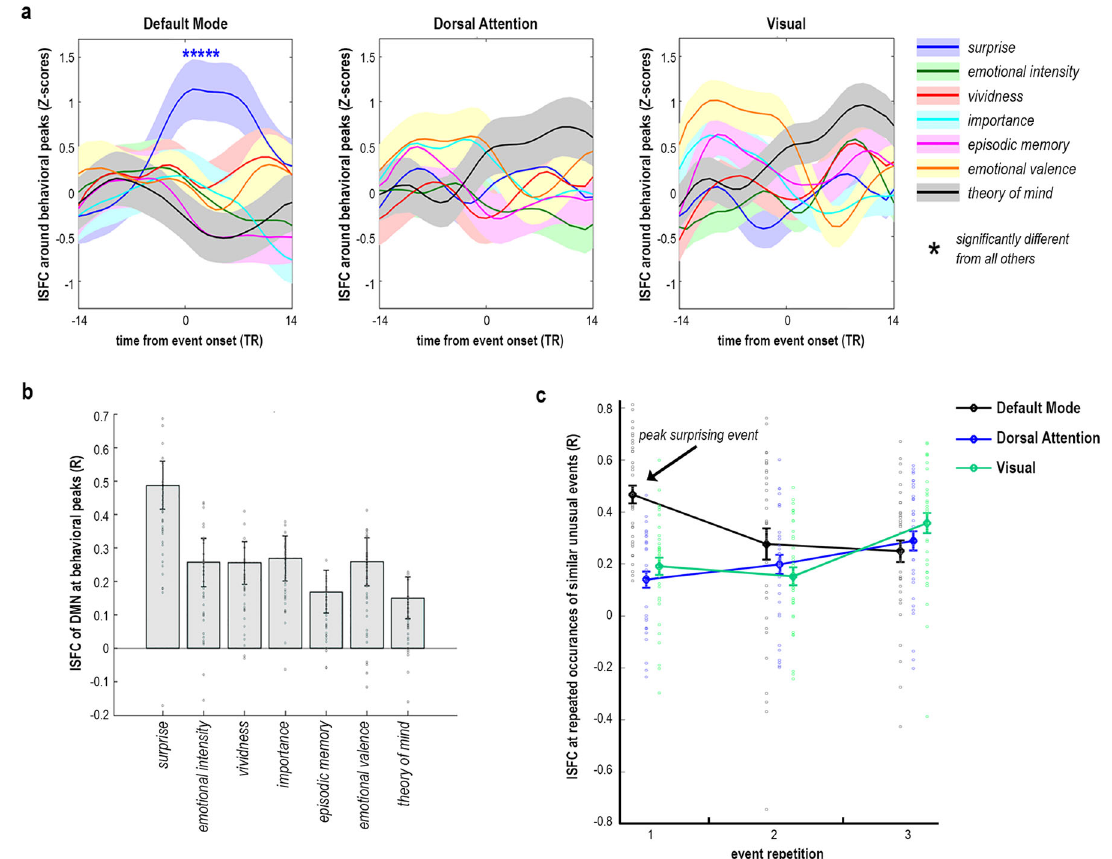
Fig. 3 Peak analysis of coactivations in Sherlock. Peak SFPA — mean ISFC time-course of n = 35 fMRI participants and of all network regions was averaged across the fi ve peak events on each behavioral measure (e.g., ISFC during fi ve most surprising events). This resulted in a mean ISFC value per network per peak-state, presented here. DMN regions were selectively coactivated during peak surprise, compared to all other peak states, as revealed by random permutation testing (1000 iterations) at p < 0.05. Network ISFC is plotted as mean ± SEM across subjects. a Peak-SFPA; t = 0 corresponds to event onset. Mean ISFC at t = 0 was calculated across a 15-TR window centered around t = 0, from − 7TR to + 7TR. Mean ISFC at t = 1 was calculated across a 15-TR window centered around t = 1, from − 6TR to + 8TR, and so on for each plotted time-bin. b Peak-SFPA, as mean DMN ISFC corresponding to event onset ( t = 0 in A). Surprise 0.49 ± 0.07, emotional intensity 0.26 ± 0.07, vividness 0.25 ± 0.06, importance 0.27 ± 0.07, episodic memory 0.17 ± 0.06, emotional valence 0.26 ± 0.07, theory of mind 0.15 ± 0.06. Scattered dots denote individual-subject ISFC values. c Mean ISFC across participants and network regions, corresponding to the onsets of three similar events within the same scene, the fi rst of which was found to generate peak surprise. The scene depicted a press conference in which the same initially-surprising text-message was sent to all attendees three times, corresponding to a decrease in mean ISFC of the DMN, but not DAN or Vis. Scattered circles denote individual-subject ISFC